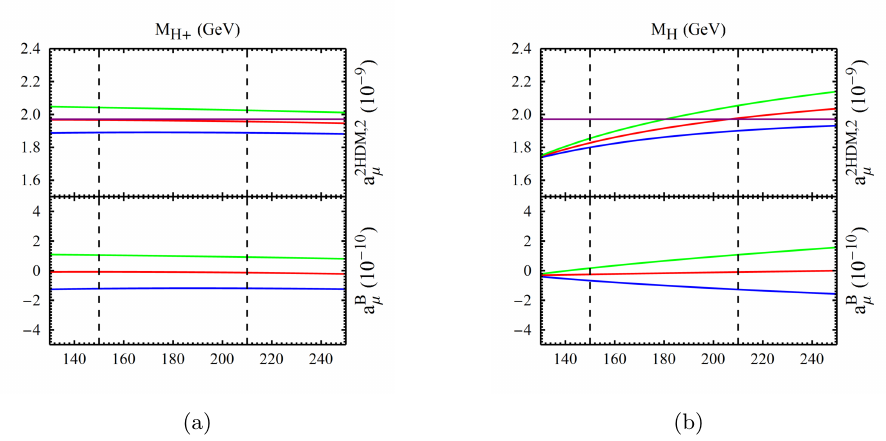
Figure 2 . Revised version of figure 11. Plots showing the behavior of a 2HDM , 2 red/blue/green line is for η = 0 / 0 . 1 / – 0 . 1 . M λ 1 = 4 π , and t β = 100 . The inside regions between the dashed lines are allowed by constraints. The purple line is a reference value as explained in the